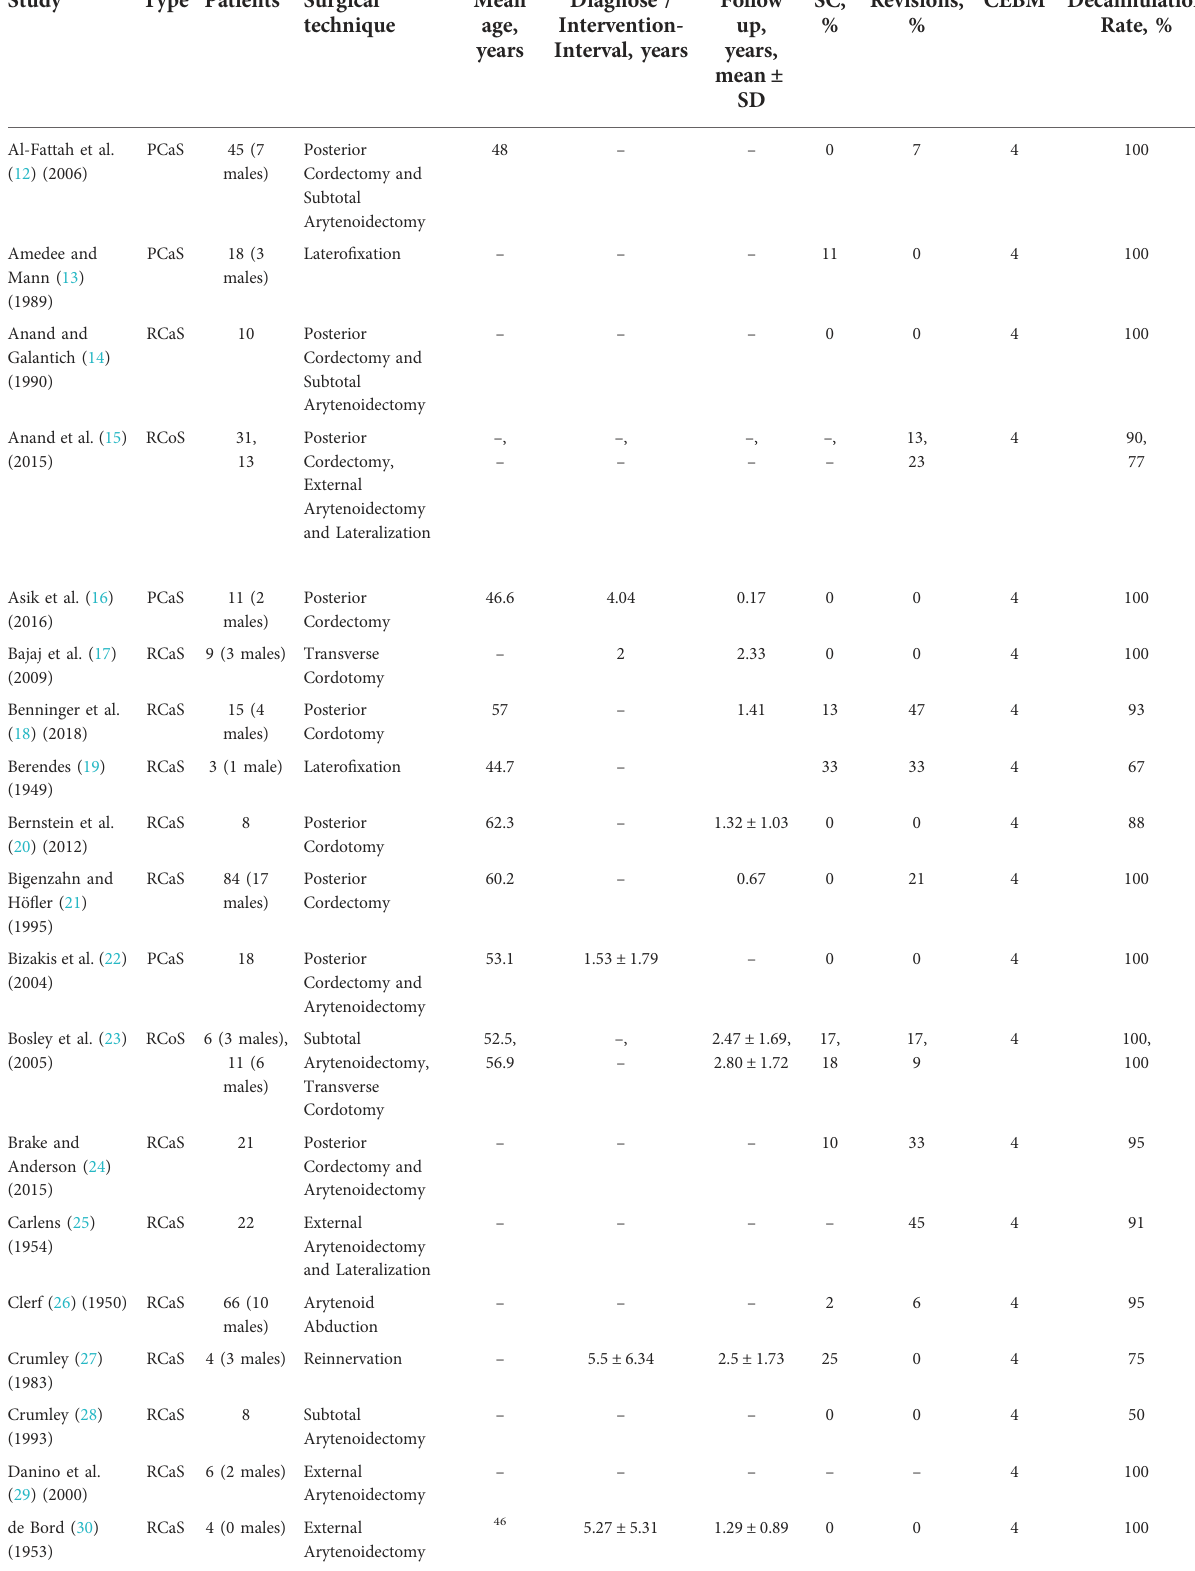
TABLE 1 List of included